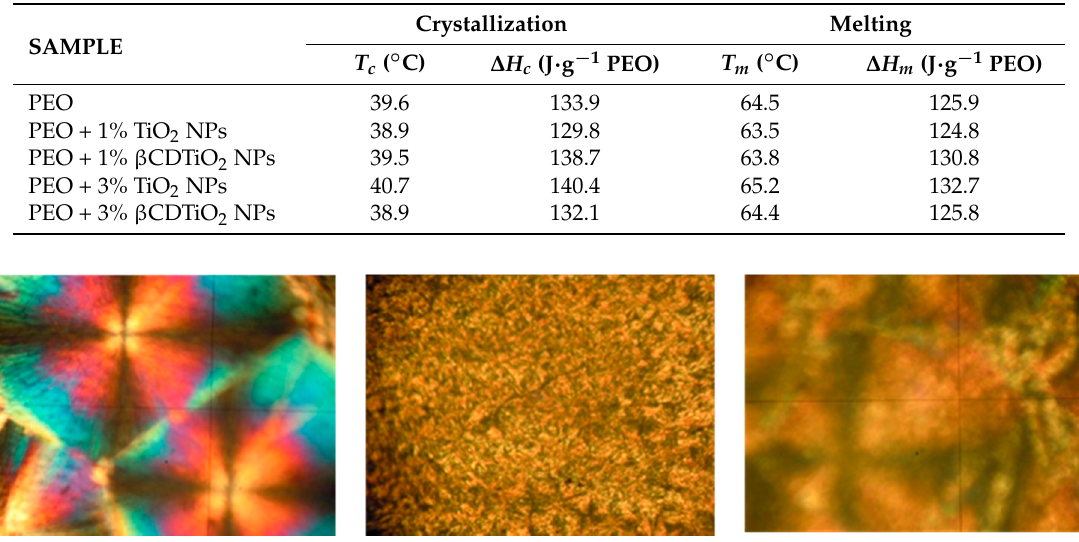
Figure 9. Polarized optical micrographs (100×) of poly(ethylene oxide) crystallites corresponding to (from left to right): pure PEO, PEO + 5% TiO 2 NPs and PEO + 5% β CDTiO 2 NPs.